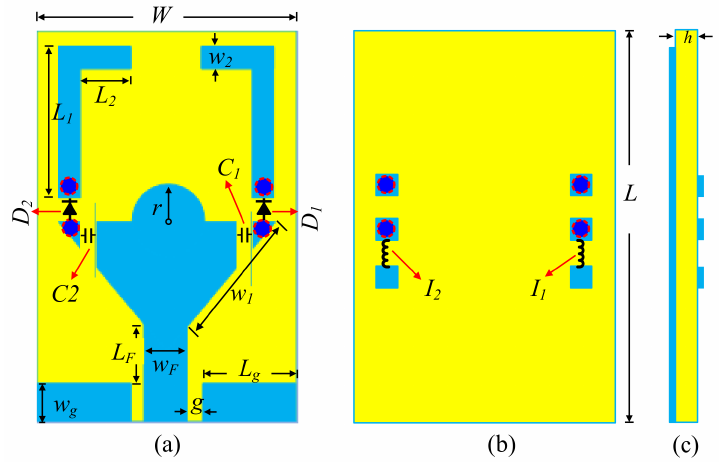
Figure 1. The geometry of the proposed antenna: ( a ) Front view, ( b ) back view, and ( c ) side view.